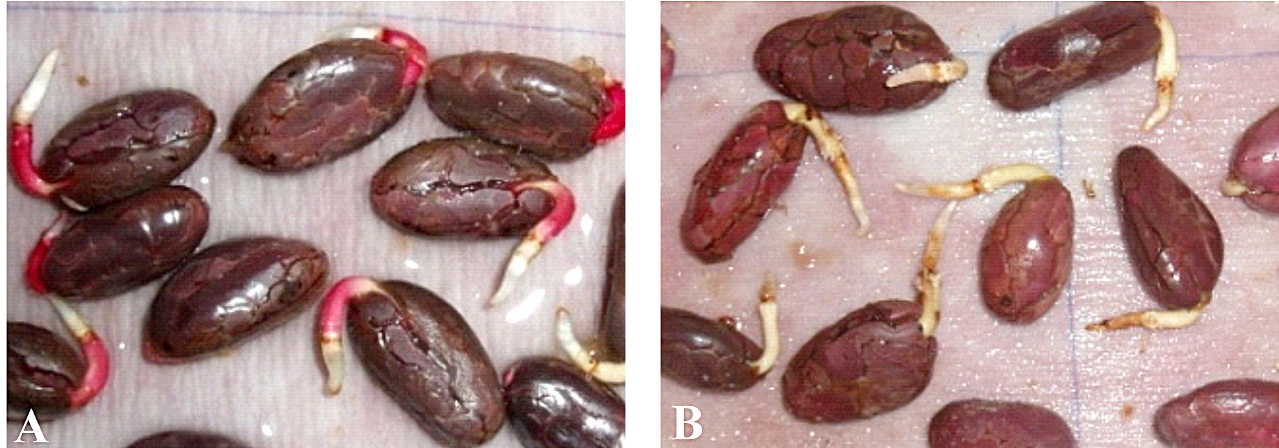
Fig. 1: Root aspect of traditional German cacao, Gc (A) and hybrid ICS40 clone (B) 6 days after germination in distilled water. The high accumulation of anthocyanin in the root is observed in Gc.